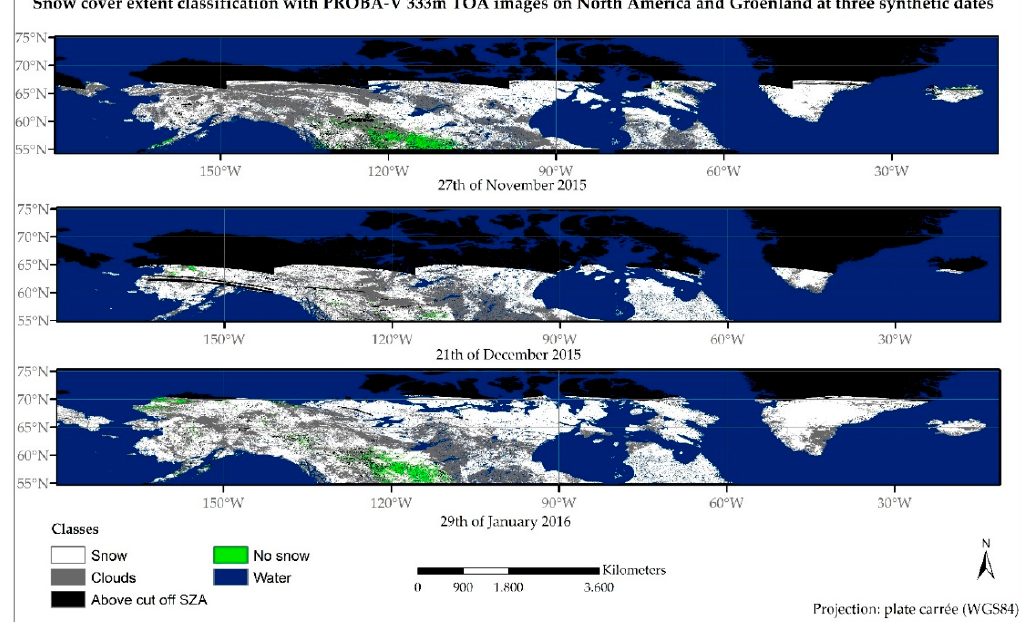
Figure 3. Snow cover extent classification with PROBA-V 333 m top-of-atmosphere images on North America and Greenland at three synthetic dates.